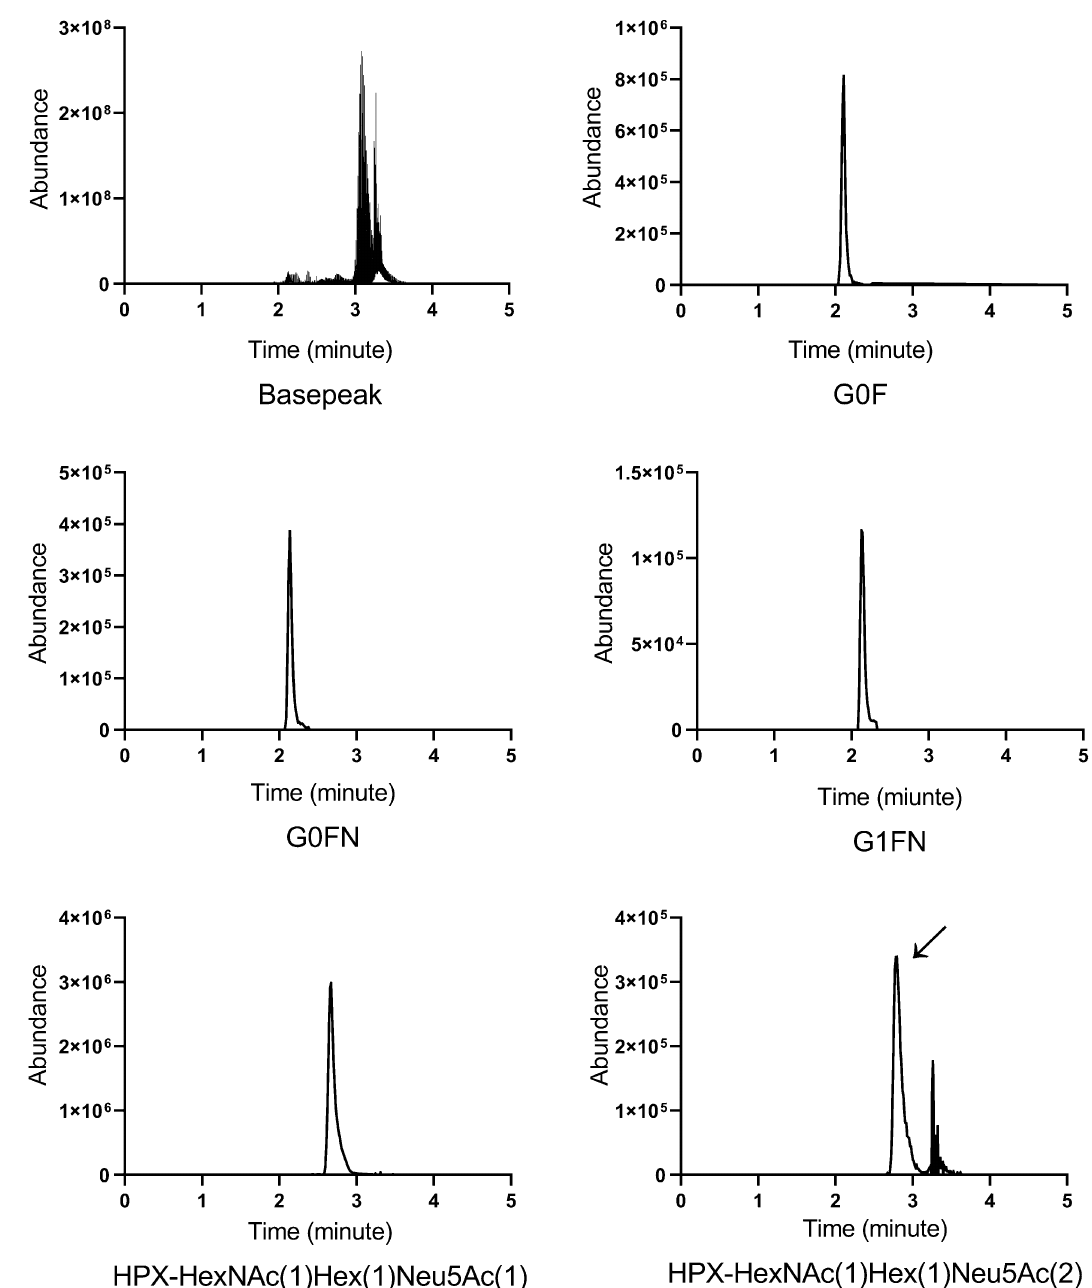
Figure 1. Representative extracted ion chromatograms showing the elution of selected IgG and HPX